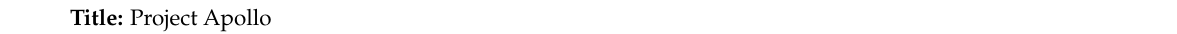
Table 5. Comparison of answer prediction on test